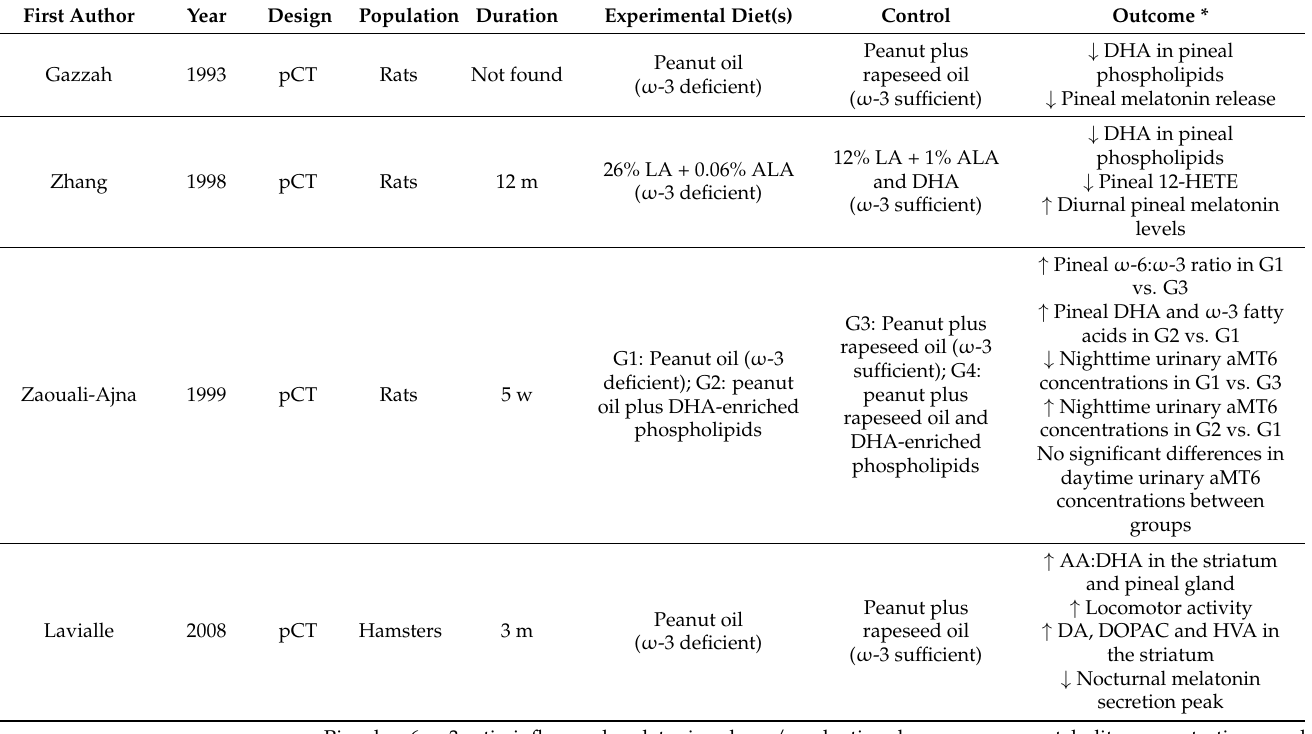
Table 1. Selected studies on the regulation of melatonin secretion by omega-3 fatty